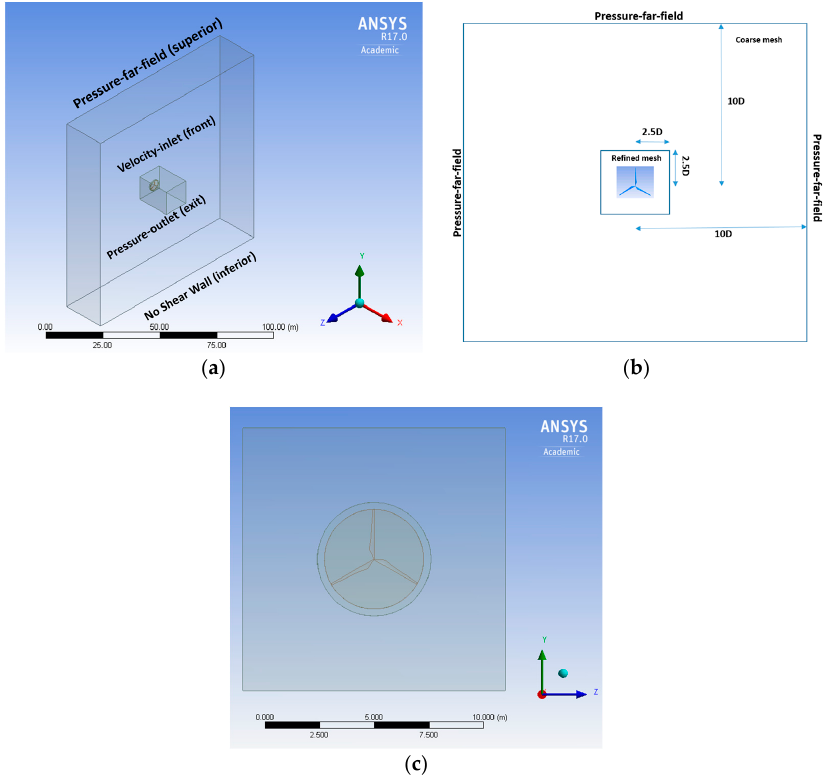
Figure 3. Layout of the computational domain and boundary conditions. ( a ) Perspective view and boundary conditions; ( b ) Information about the physical domain; ( c ) Front view of the central disc.